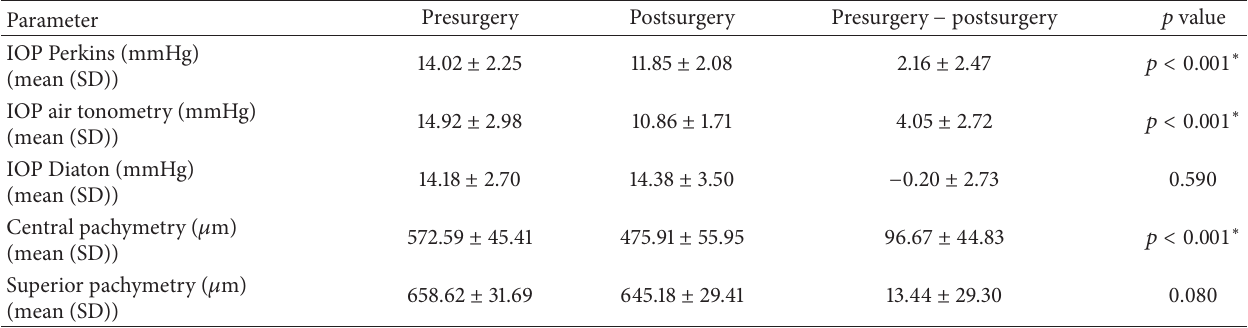
Table 2: Intraocular pressure readings with Perkins, air and Diaton tonometers, and central and superior pachymetries before and after